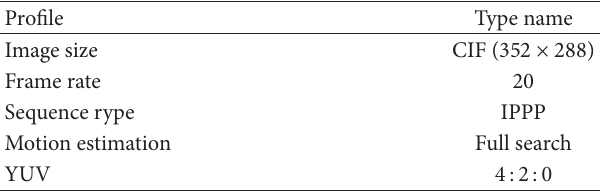
Table 3: Parameters of experimental